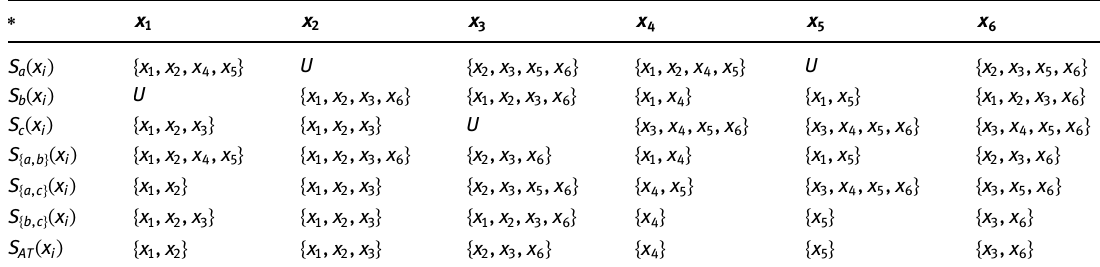
Table 7: The similarity classes of elements in Example 3 ∗ x 1 x